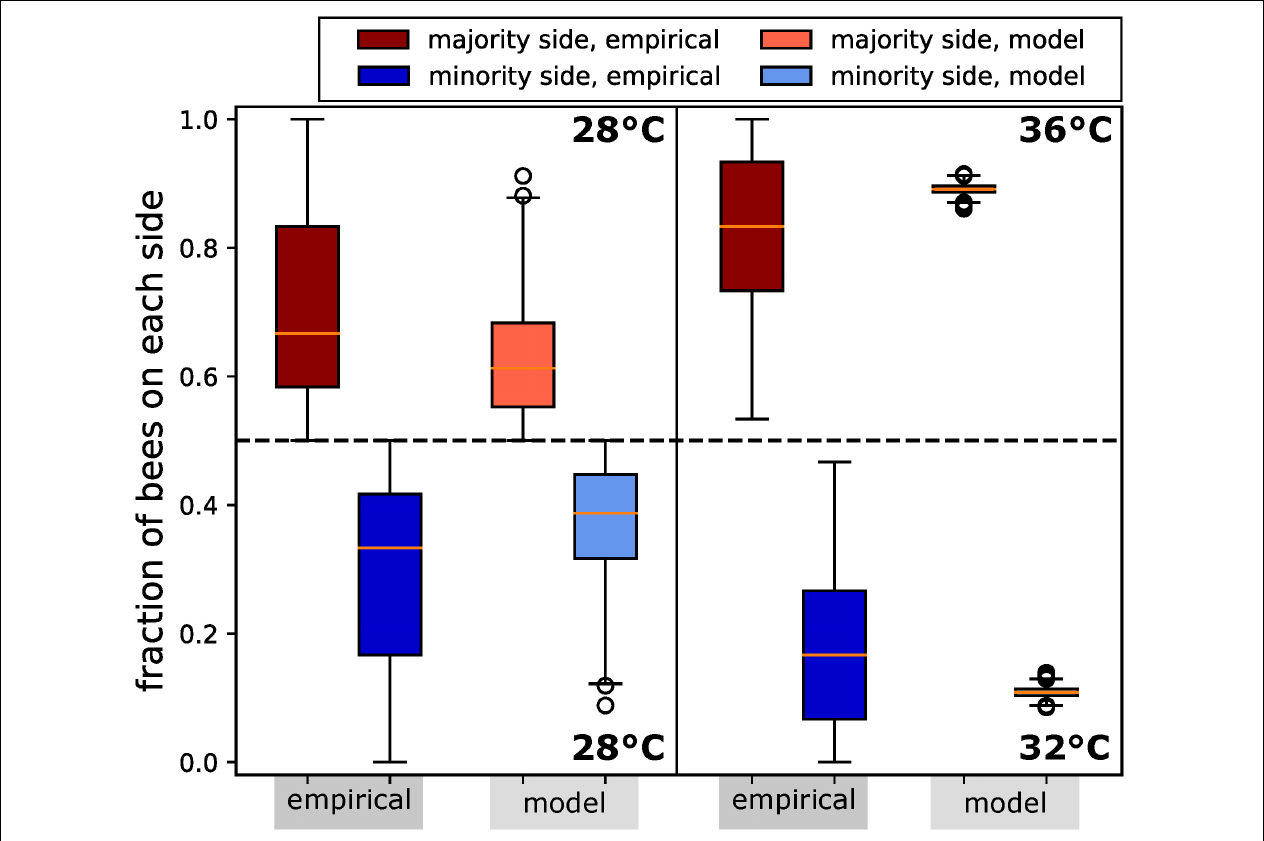
FIGURE 7 | Honeybee group decision making in fixed environments, from empirical study and ordinary differential equation (ODE) model as described in the text. Two scenarios are considered: (1) a homogeneous environment, where the two choices are equal at 28 ◦ C, with N = 14 repetitions; (2) a heterogeneous environment, with one global optimum of 36 ◦ C and one local optimum of 32 ◦ C, with N = 12 repetitions. We measured the number of bees on the side with the majority for the period of 8–13 min. Since the group size differed between the two experimental settings, we report in fraction of the total group. We also display the distributions of fractions on the minority side. In setting (2), each bee group makes substantially stronger decisions than in setting (1), where there is no environmental difference to select on. Despite this, their social preference means that in setting (1), we still observe bees forming aggregations on one or another side to some degree. In both settings, the model generates a lower variance but otherwise predicts the aggregation effect corresponding to the empirical